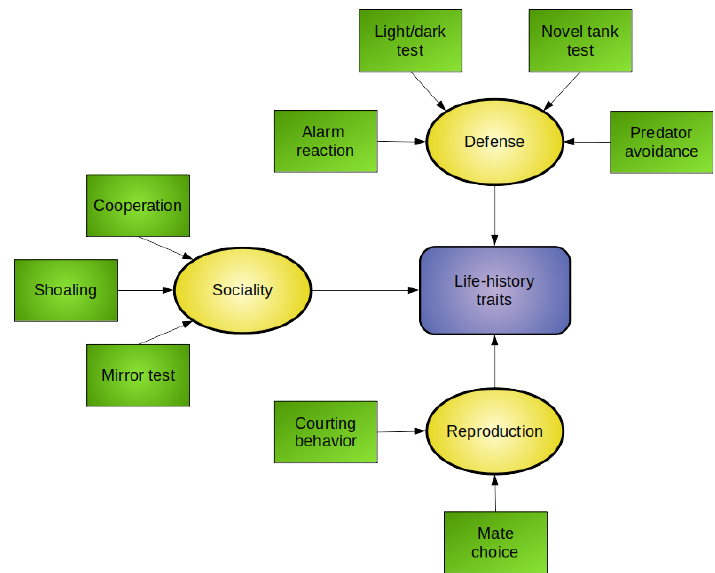
Figure 2. Well-controlled laboratory experiments, using more than one test, can determine whether the effect of a given toxicant impacts one or more behavioral domains that are likely to affect complex responses (reproduction, defense, sociality) that are related to life-history traits, and likely to impact responses at population, species, community, and ecosystem levels.